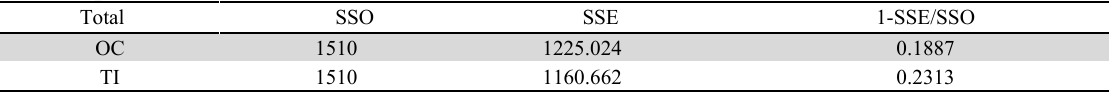
Result of predictive Relevance of the